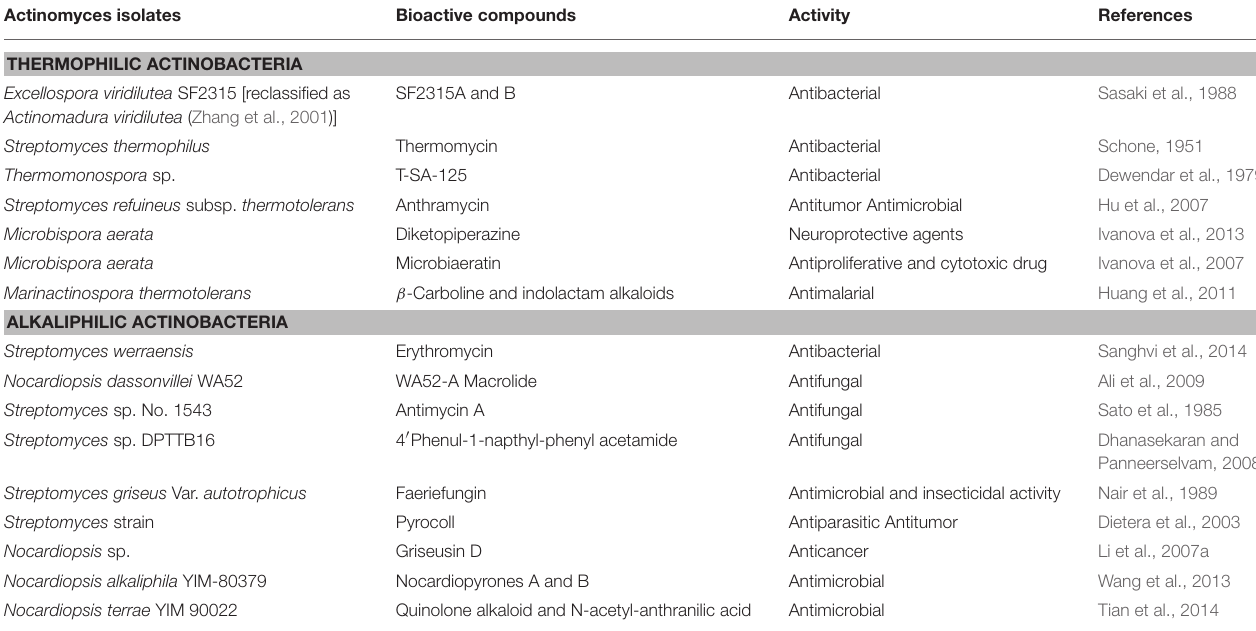
TABLE 3 | List of bioactive compounds produced by thermophilic and alkaliphilic